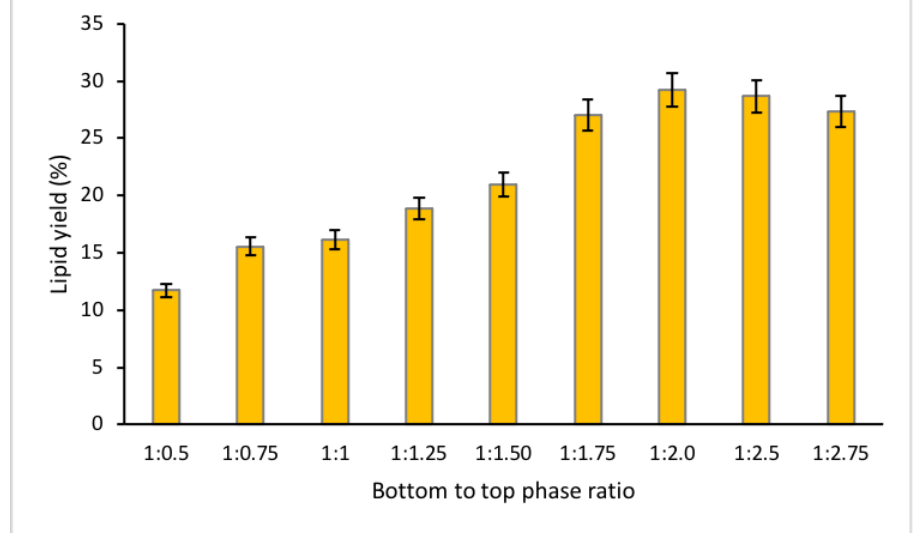
Figure 4. Percentage of lipid recovered with different bottom to top phase ratio .